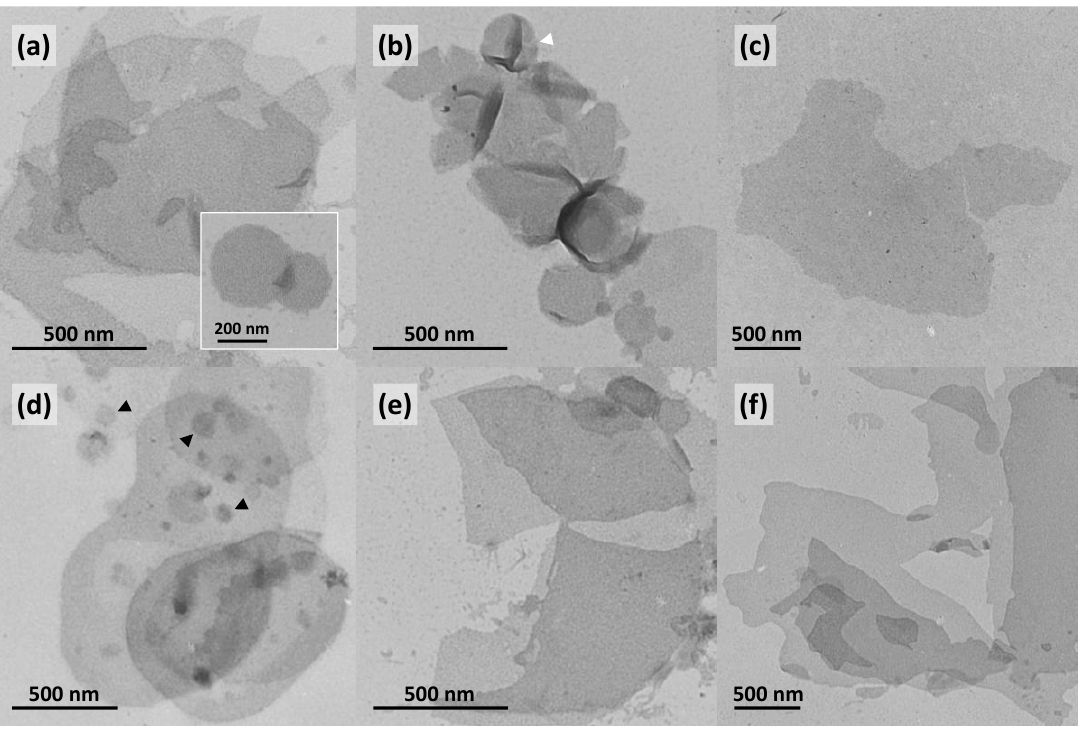
Figure 8. TEM images of aqueous suspensions ( c = 0.05 mg mL −1 ) of Me 2 PE-Gly(2C16)C32-OH :DPPC mixtures at different molar ratios: 1:4 ( a – c ); and 1:1 ( d – f ); in acetate buffer at pH = 5.0 ( a , d ); phosphate buffer at pH = 7.7 ( b , e ); and carbonate buffer at pH = 10.0 ( c , f ), at different magnifications. The inset in ( a ) shows a small round aggregate. The white arrowhead in ( b ) points to a crushed vesicle, whereas the black arrowheads in ( d ) point to small aggregates. Samples were prepared at 22–24 °C and stained with uranyl acetate.